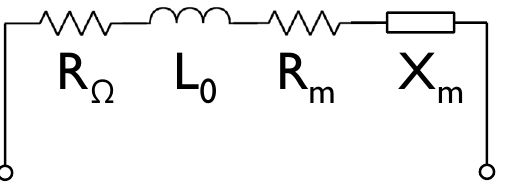
Figure 1. Lumped equivalent circuit representation of an inductive antenna spin-wave transducer. The equivalent circuit consists of an Ohmic series resistance ( R (cid:31) ), a self-inductance ( L 0 ), as well as a radiation resistance ( R m ) and reactance ( X m ) that capture the power coupling to FMR or spin